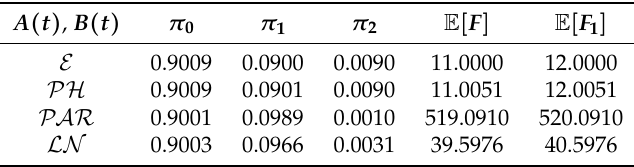
Table 1. π i , i = 0,1,2, E [ F ] and E [ F 1 ] versus A ( t ) and B ( t ) .